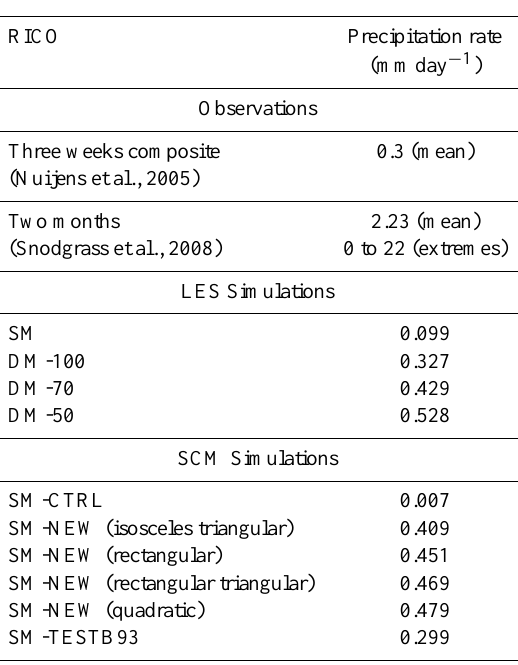
Table 6. Observed and simulated surface precipitation rates for